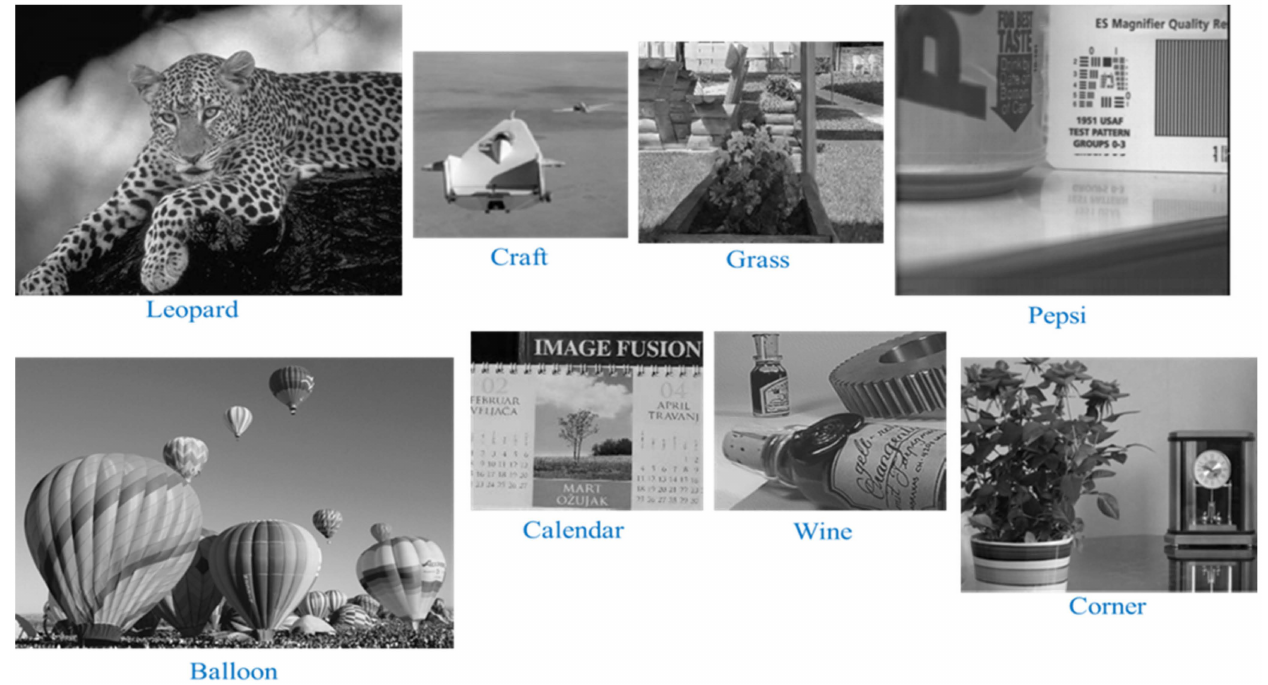
Figure 19. Fusion results of the proposed method for the multi-focus image pairs shown in Figure 17.